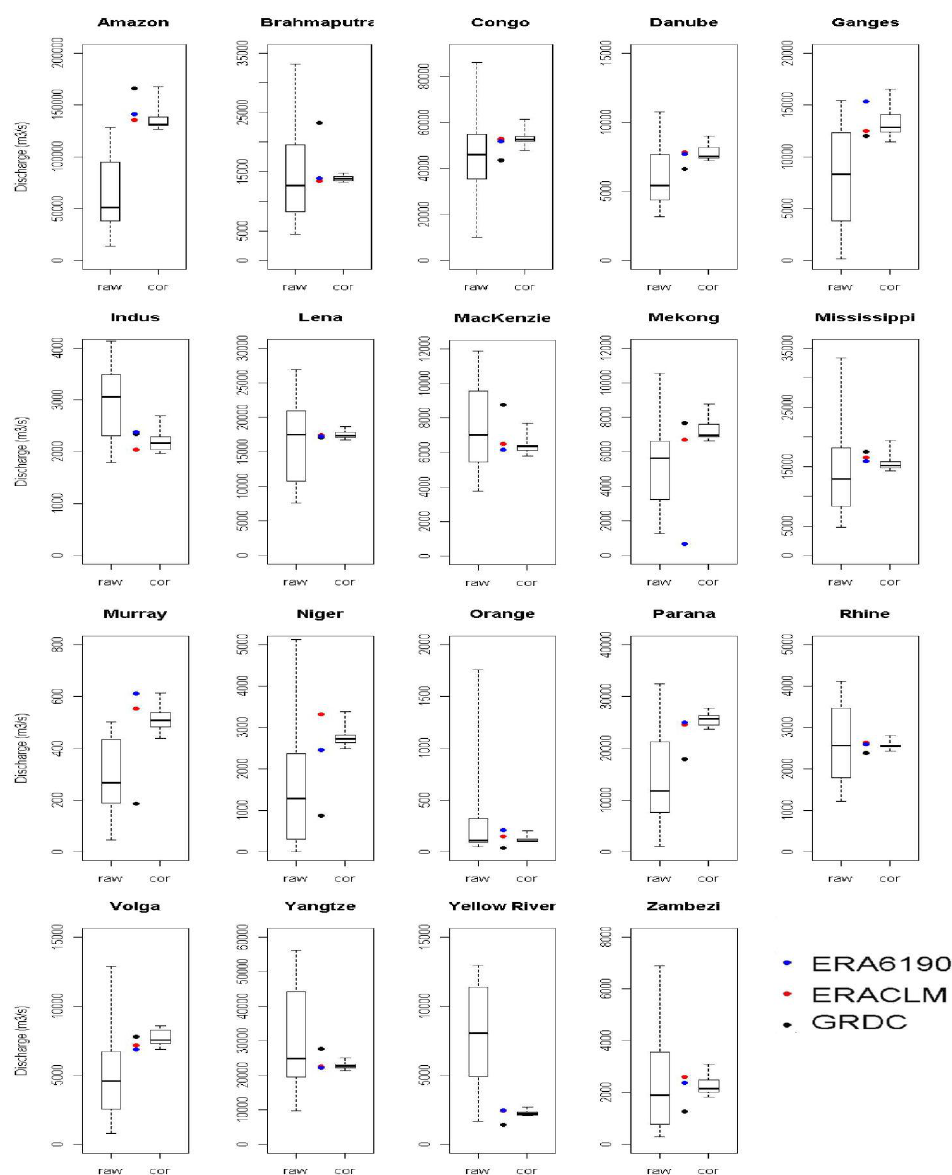
Figure 8: Boxplots obtained form the 30-year average mean discharges of the ensemble of non-bias corrected GCM runs (raw) and bias-corrected GCM runs (cor; boxes are drawn between the quartiles and whiskers represent minimum and maximum values). The points show 30-year average mean discharges of the ERA6190 run (blue), ERACLM run (red) and GRDC observations (GRDC).